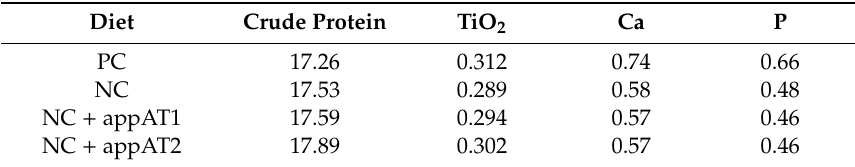
Table 3. Ca, P, crude protein, and marker content (%) in the positive control (PC), negative control (NC), and NC diets supplemented with phytase (appAT1 or